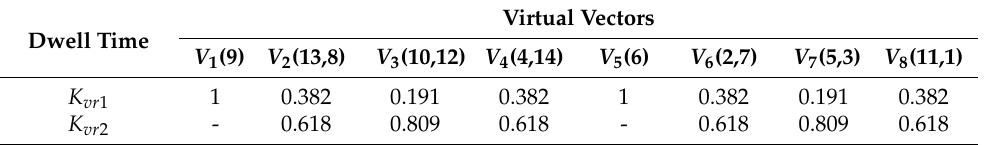
Table 2. Dwell times during the